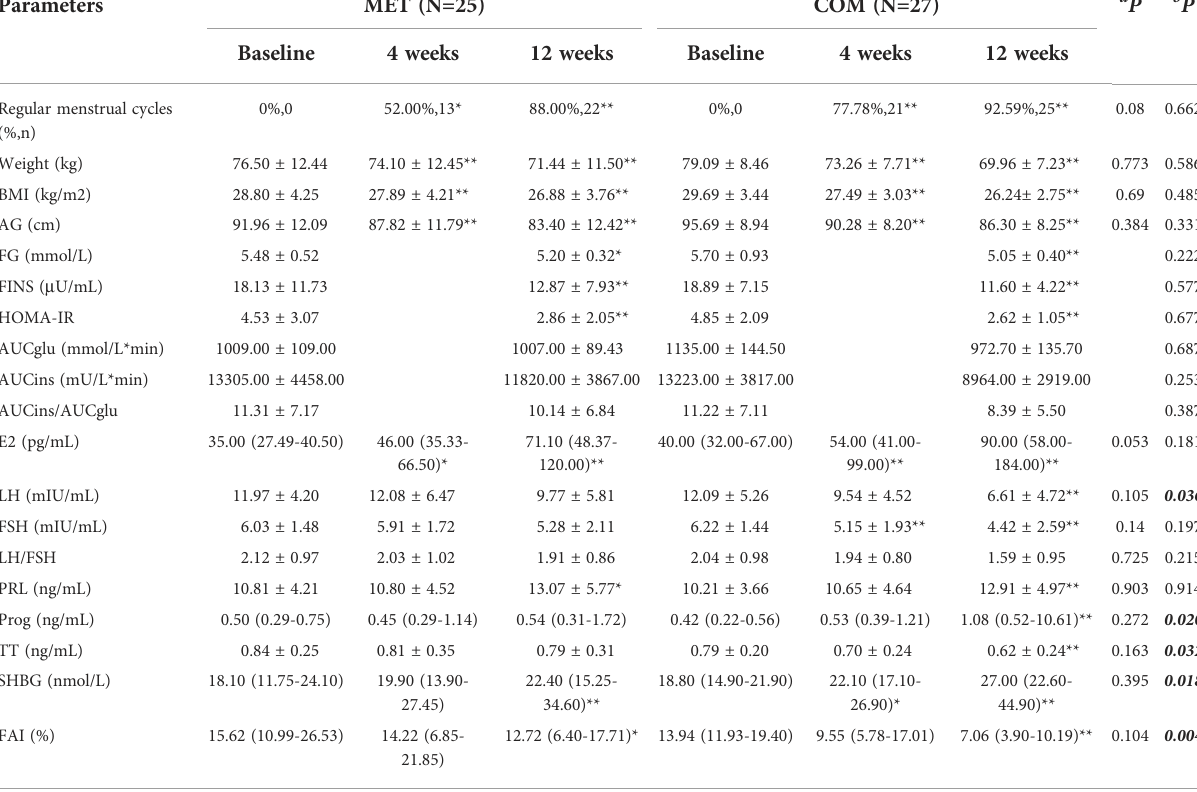
TABLE 2 Changes of hormonal, metabolic and anthropometric parameters.